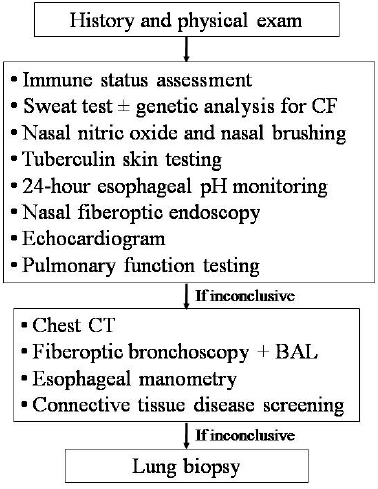
Figure 3. Diagnostic work-up for children with recurrent pneumonia in different areas. CF, cystic fibrosis; CT, computed tomography; BAL, bronchoalveolar lavage.